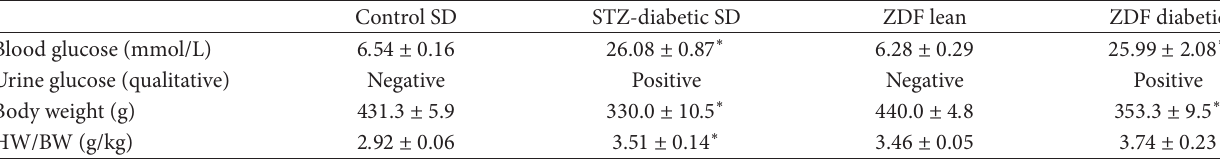
Table 2: Blood and urine glucose, body weight, and heart weight to body weight ratio.